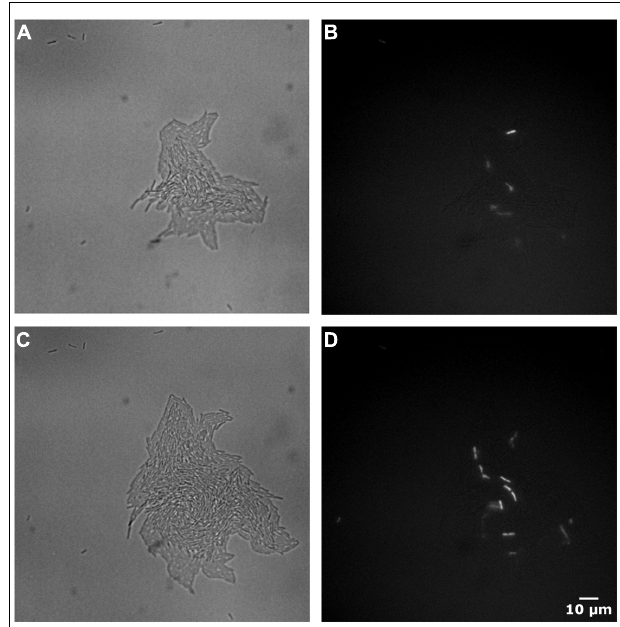
FIGURE 4 | Images of brightfield and PI fluorescent of JK09 after anaerobic cultivation followed by exposure to PAA. Brightfield at 44 h (A) , propidium iodide (PI) fluorescent at 44 h (B) , brightfield at 48 h (C) , PI fluorescent at 48 h (D) .